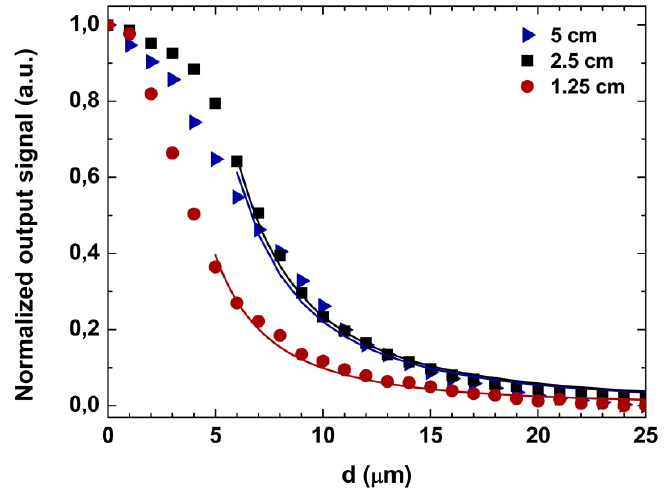
Figure 3. Intensity response of the sensor with displacement changes, for three different cavity